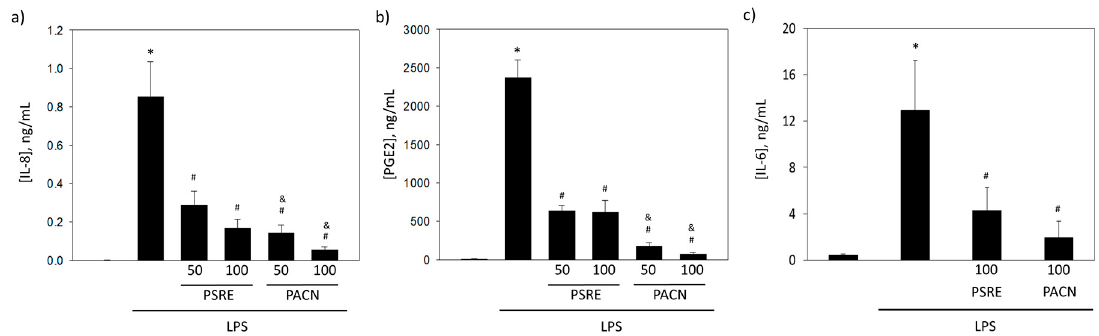
Figure 5. The effect of Pelargonium sidoides root extract (PSRE) and proanthocyanidins from PSRE (PACN) on ( a ) interleukin-8 (IL-8) and ( b ) prostaglandin E2 (PGE2) secretion from gingival fibroblasts, and (c) interleukin-6 (IL-6) secretion from peripheral blood mononuclear cells after LPS treatment. Fifty and 100 represent the concentrations (µg/mL). The data are presented as means and standard deviations of seven experiments. *—significant difference compared to untreated control, #—significant difference compared to LPS only treatment and &—significant difference compared to LPS plus a 50 µg/mL PSRE treatment, p < 0.05.